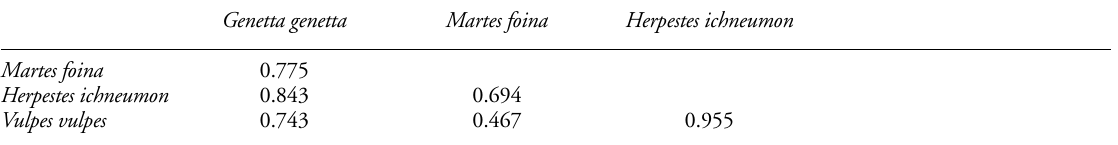
Table 2. Pianka’s trophic niche overlap in pair-wise comparisons between the study species (0 – no overlap; 1 – complete overlap in trophic